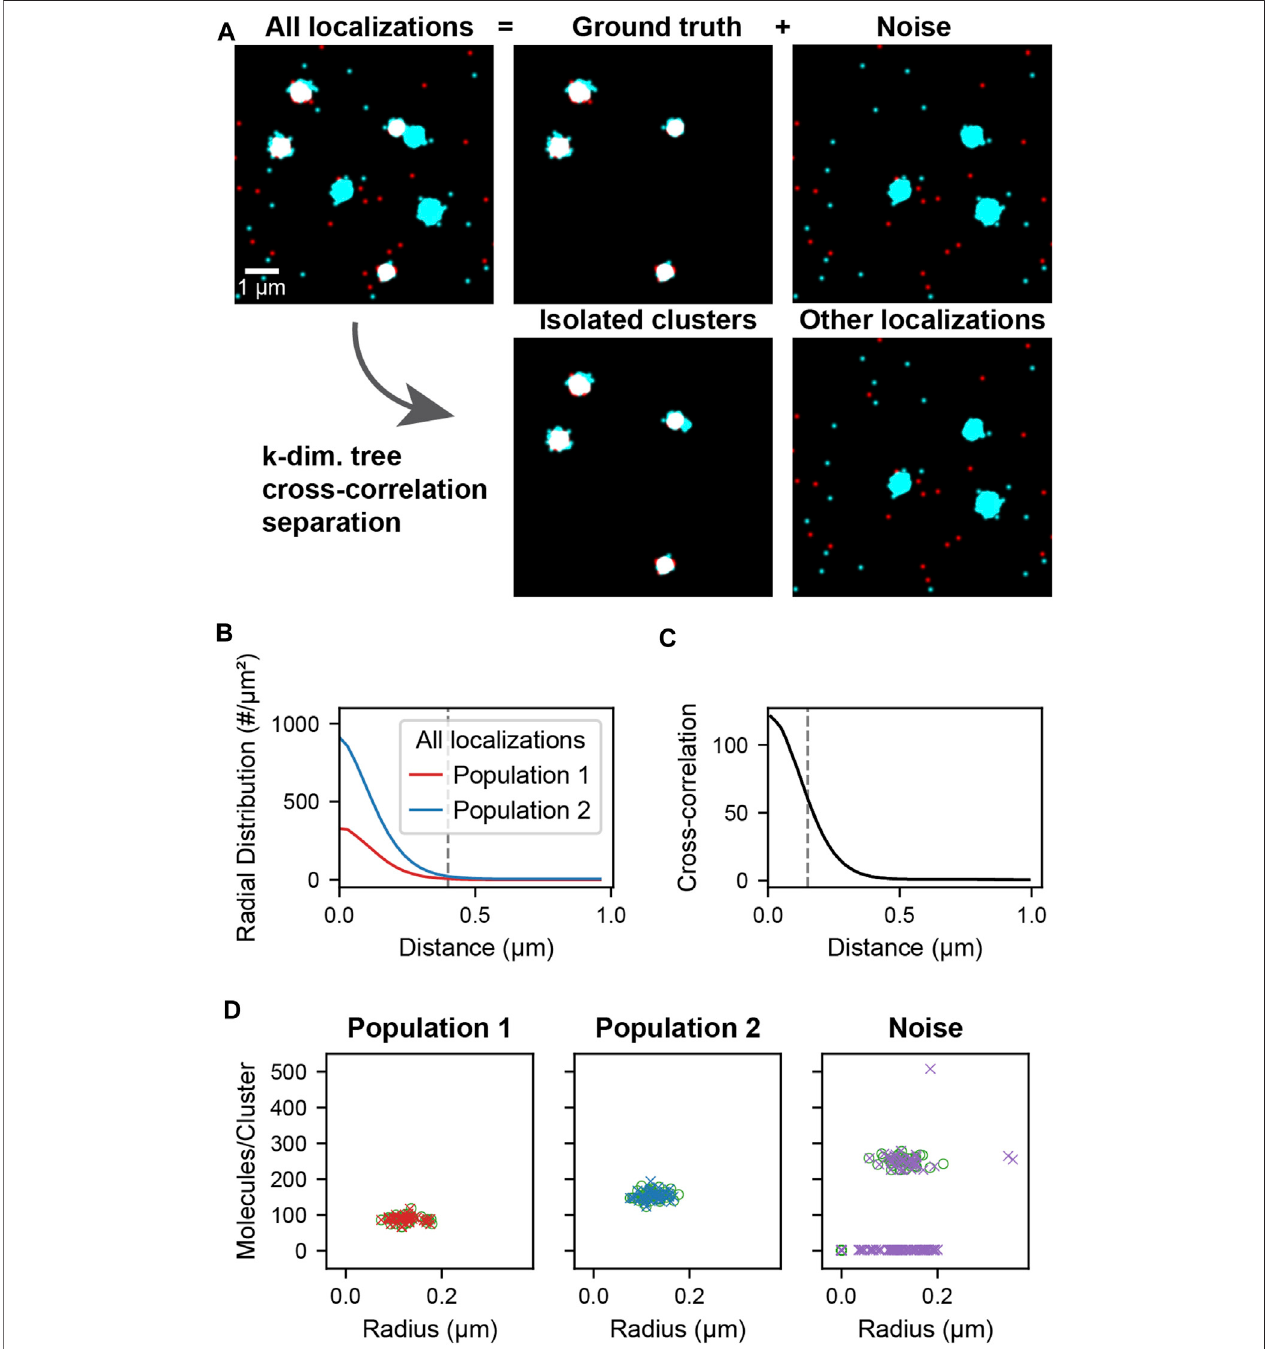
FIGURE2| Clusterseparationonsimulateddata.Adatasetwassimulatedconsistingoftwotypesoflocalizationsaswellasaddednoise.Population1(red)and2 (cyan) consists of 40 clusters of size 0.1 ± 0.02 µm and stoichiometries of Poisson (90) and Poisson (150) respectively and represents the ground truth. Noise localizations include non-colocalized clusters of size 0.1 ± 0.02 µm and stoichiometry Poisson (250) (cyan) as well as randomly distributed localizations (red) to measure the performance of the cluster separation. (A) Super-resolution reconstruction of all localizations, the ground truth clusters of population 1 and 2, and the noise localizations (upper). After applying the distance-based cutoff, the two molecule lists can be separated into the colocalized clusters and all other remaining noise localizations (lower). (B) Pair correlation functions of each of the two ground truth populations showing the relevant length scale of cluster sizes used to identify clusters. (C) Cross-correlation functions of all localizations between the two populations for all localizations. The dashed line indicates the maximum separation two localizations can have to be classi fi ed as colocalized. If two localizations that belong to clusters as identi fi ed in B are closer than this maximum separation, all localizations from the entire clusters are classi fi ed as colocalized. (D) Stoichiometry and size of ground truth (circles) and recovered clusters (crosses) for each of the populations.